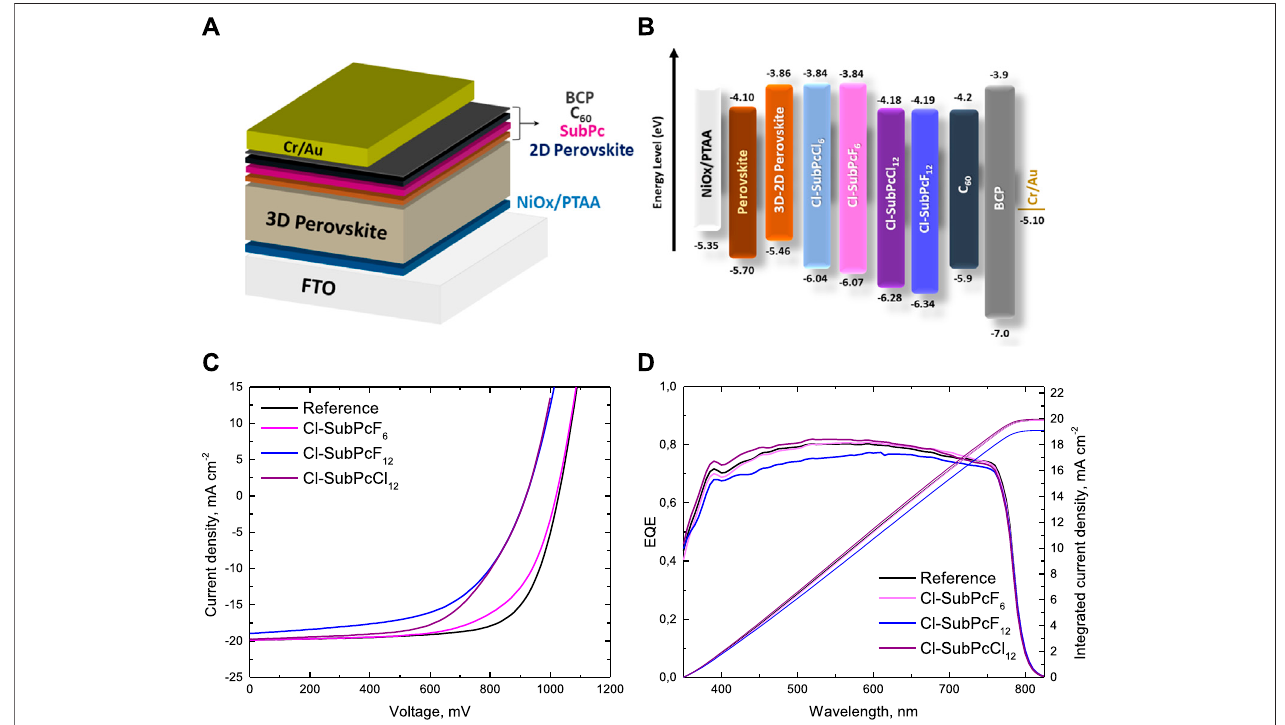
FIGURE 2 | p-i-n solar cells containing SubPc/C 60 as the ETL. (A) Scheme of the perovskite solar cell structure. (B) Energy level diagram of the device. (C) J – V curves and (D) EQE spectra and the corresponding integrated short circuit current of the most ef fi cient devices containing 2 nm Cl-SubPcF 6 , Cl-SubPcF 12 and Cl- SubPcCl 12 . The J – V curve and the EQE spectrum of the control device (black line) were added for comparison.